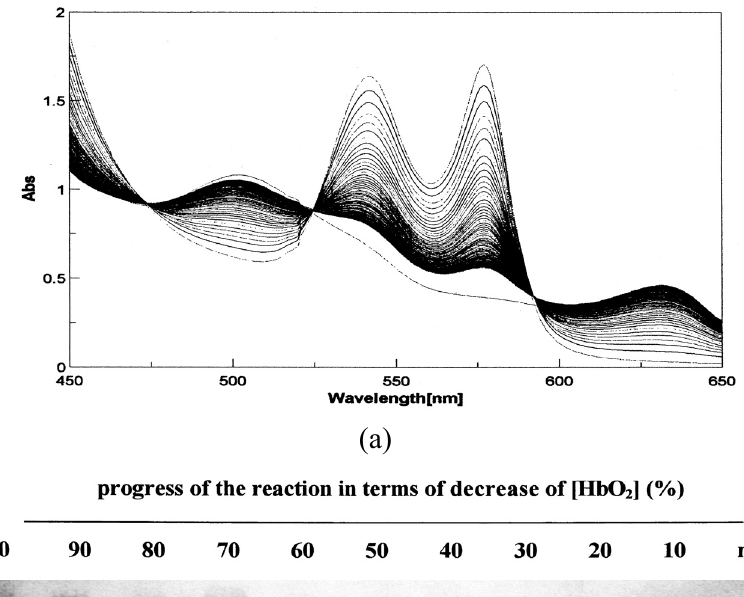
Figure 7. The available data resulting from UV/VIS spectrophotometric, isoelectric-focusing electrophoretic and polyacrylamide gel electrophoretic measurements for autoxidation of human HbO . The reaction proceeded in the presence of 20% ( v / v ) glycerol in 0.05 M 2 phosphate buffer (pH 5.0) at 37 °C. ( a ) Spectrophotometric changes from 450 nm to 650 nm with scanning interval = 10 min; ( b ) isoelectric-focusing electrophoretic profiles; and ( c ) polyacrylamide gel electrophoretic